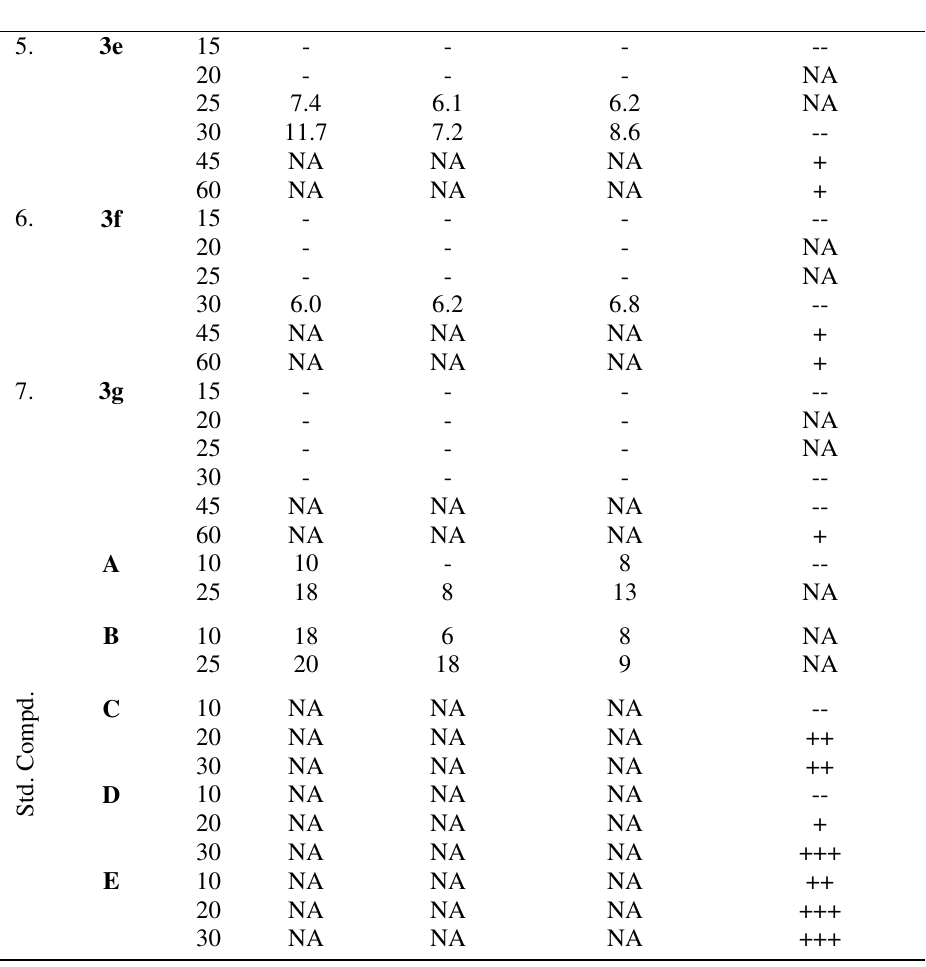
Antibacterial activities were determined in three different strains and represented as zone of inhibition (mm). Antifungal activities were determined in a single